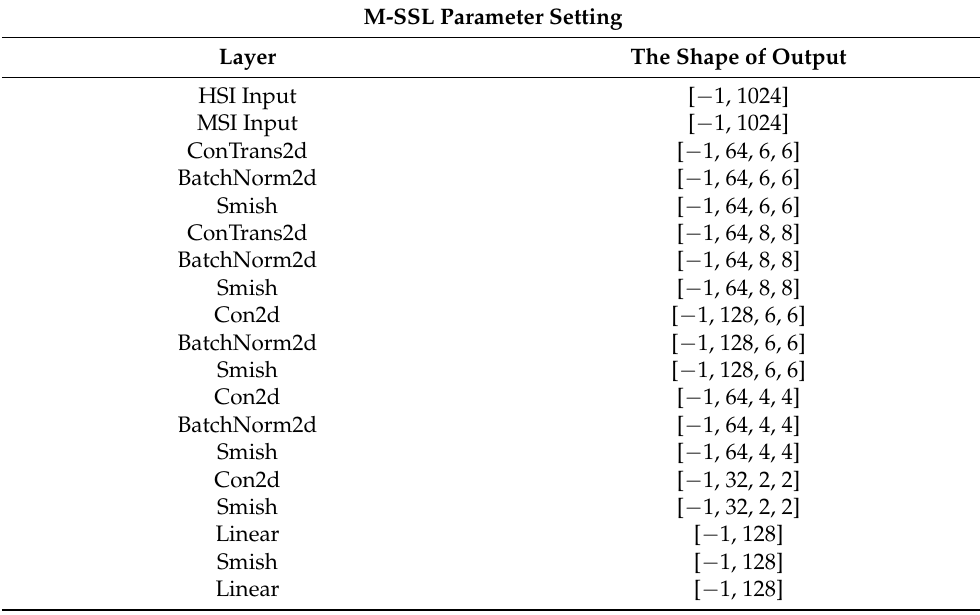
Table 10. The shape of layers in the M-SSL